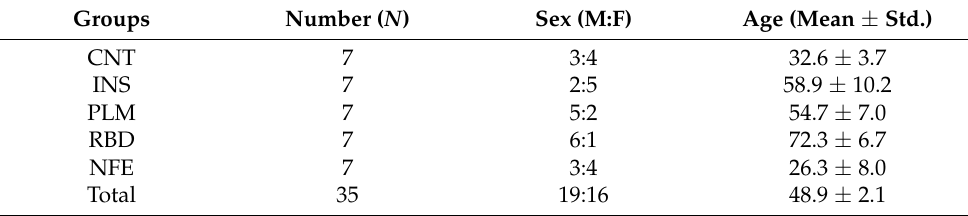
Table 1. Demographics of the study